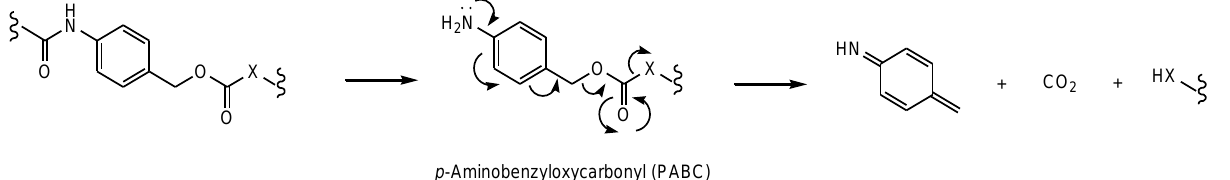
Figure 3. The self-immolative mechanism of p -aminobenzyloxycarbonyl (PABC). X represents an arbitrary heteroatom such as N or O.